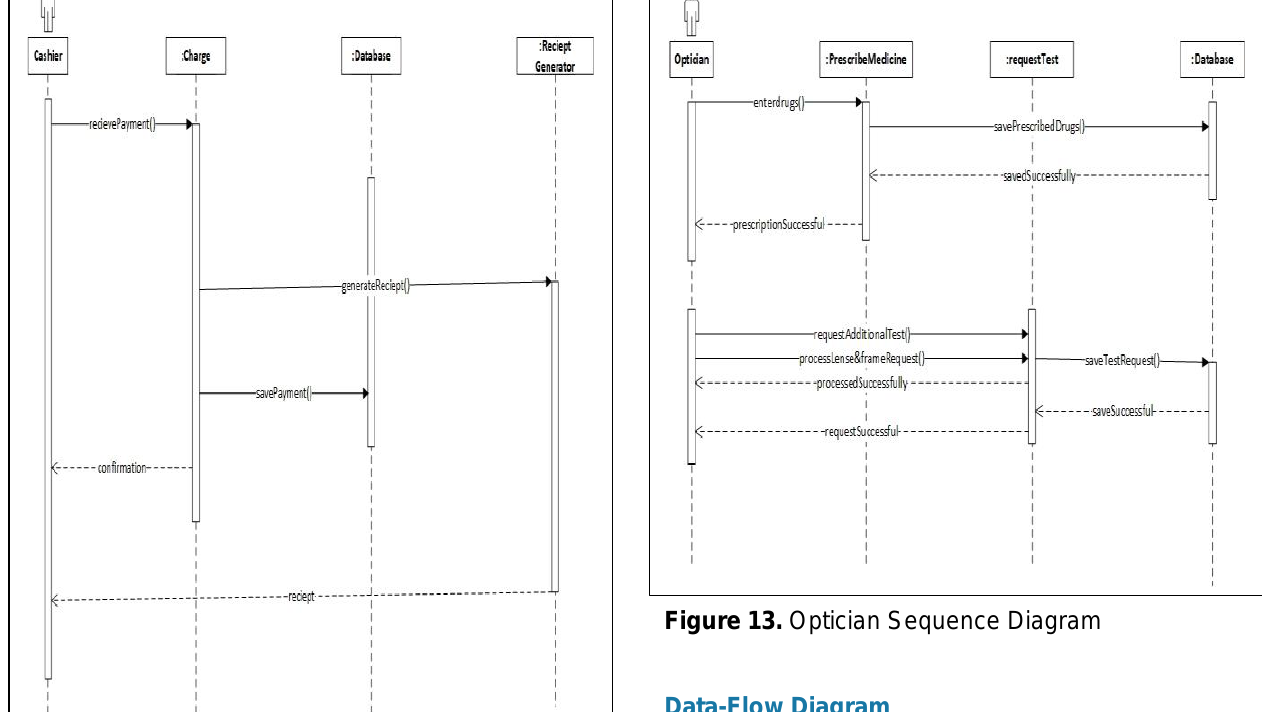
Figure 8. Login Sequence Diagram